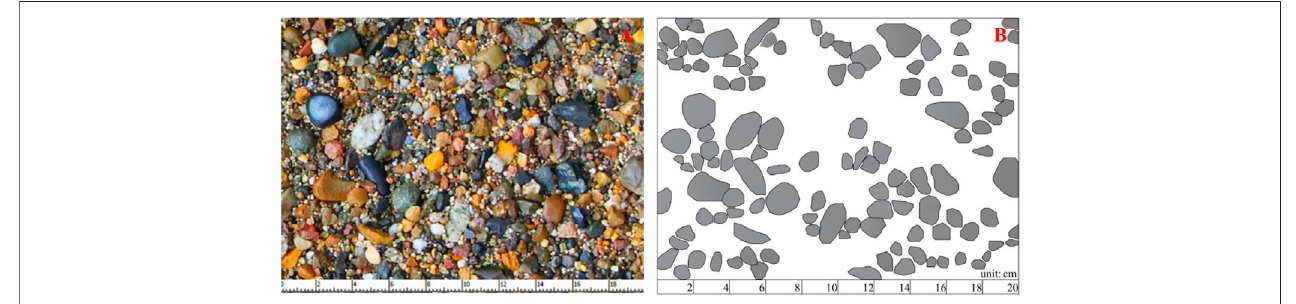
FIGURE 3 | Surface morphology of the static armor layer (A) Actual image of the static armor layer, (B) Distribution of large-grained gravel (width 20